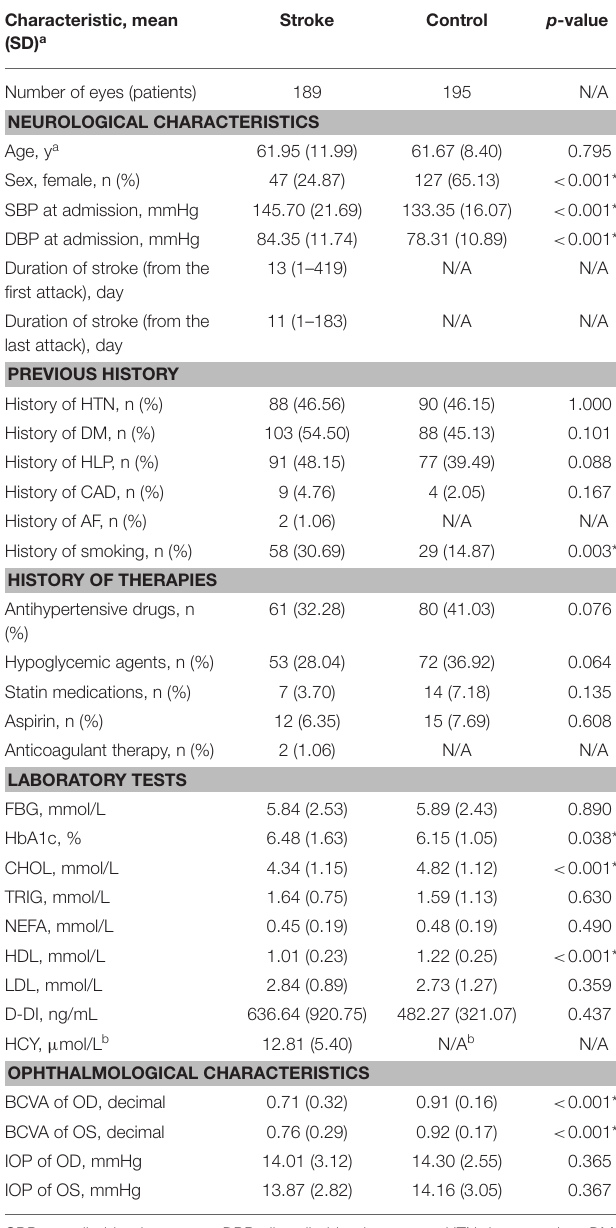
TABLE 1 | Demographic and clinical data of the two groups ( n =